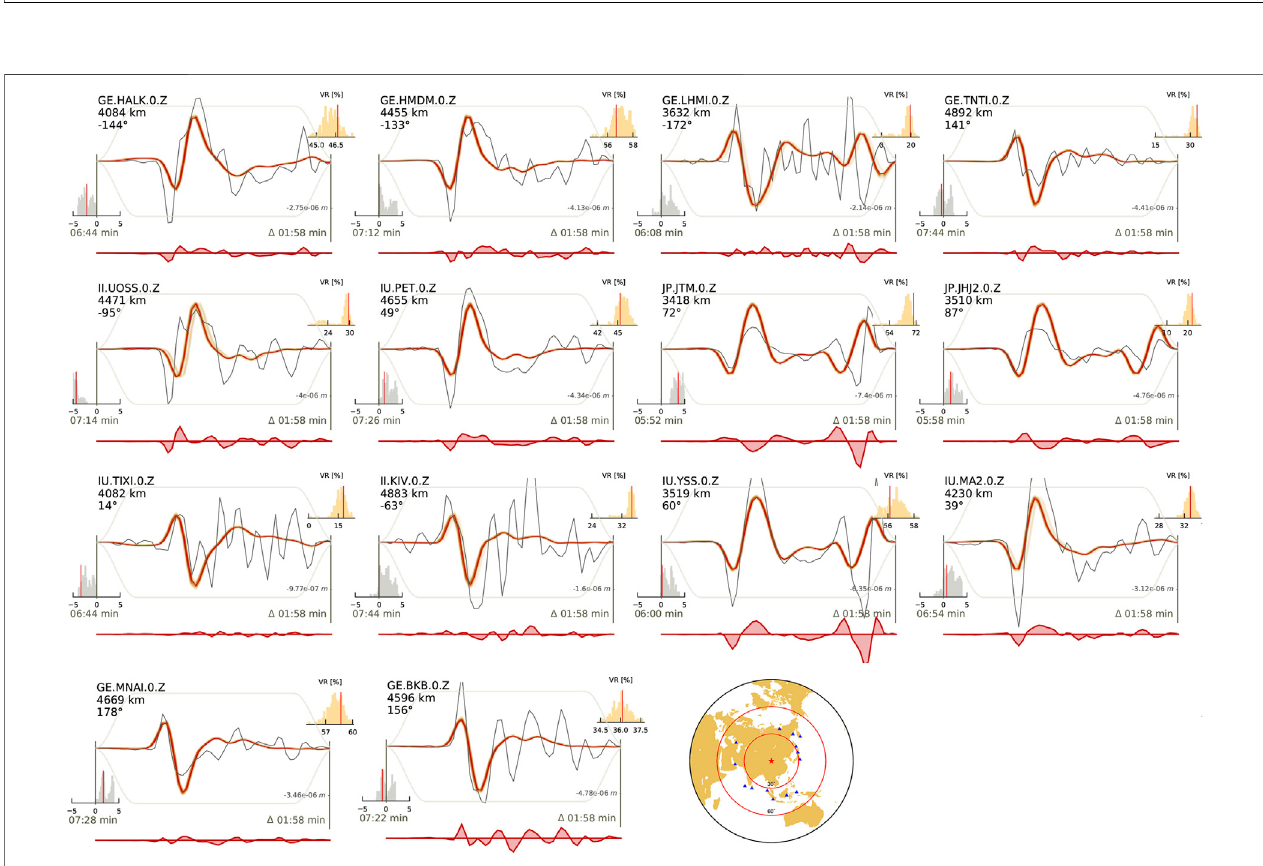
To further understand the distribution of the co-seismic deformation fi eld of this earthquake, two pro fi les across the fault are extracted from the deformation fi eld acquired by the ascending and descending imagery, respectively. The pro fi le lines A1-A2 and B1-B2 are distributed perpendicular to the line of